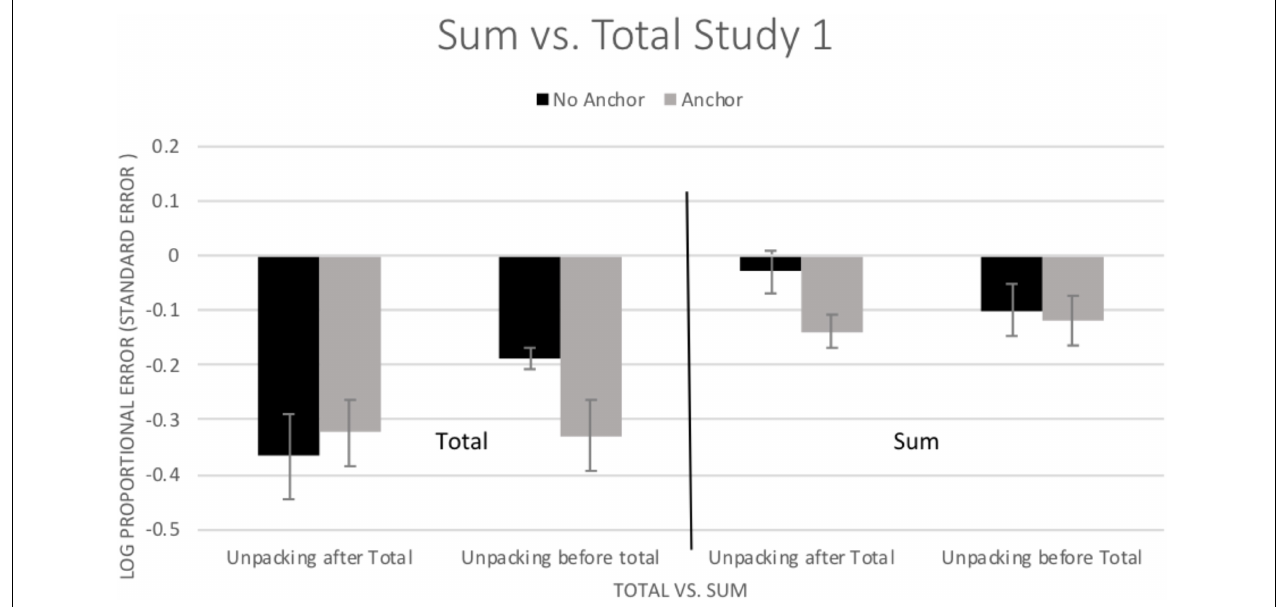
FIGURE 2 | Mean ( ± 1 SE ) bias in estimated duration (log of estimated duration/actual duration) for the total duration estimation and for the sum of the segments. Positive values indicate overestimation and negative values indicate